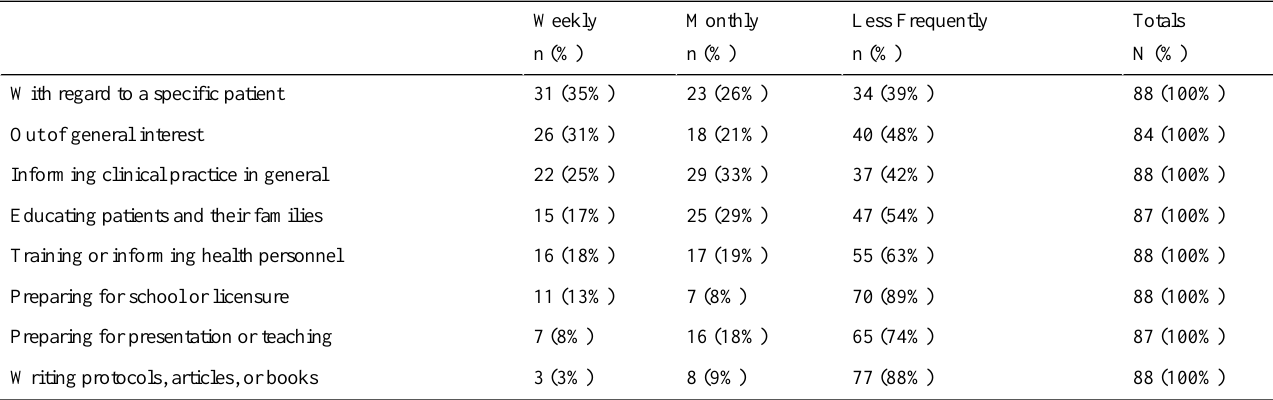
Table 4. Reasons for accessing health research